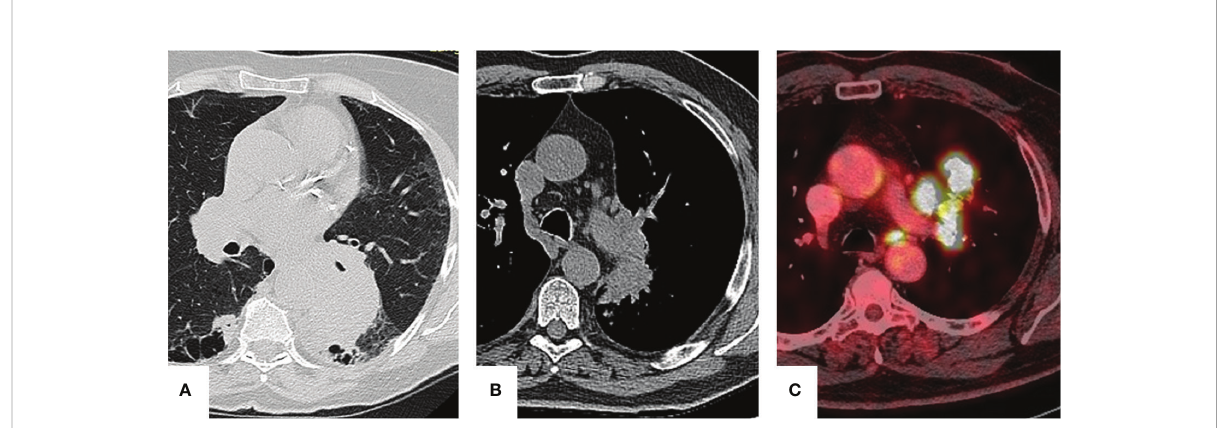
FIGURE 1 Preoperative imaging. Patient A : a 7-cm lesion is seen in the left lower lobe. Patient B : perihilar lesion with in fi ltration of bronchopulmonary lymph nodes. Patient C : para-aortic lymph node